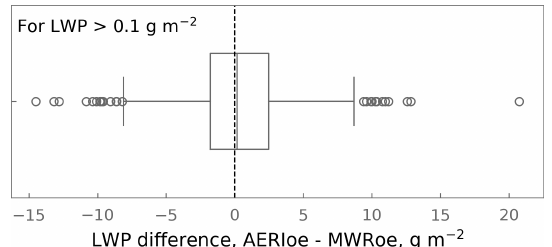
Figure 8. The differences in retrieved liquid water path (LWP) be- tween all AERIoe and the MWRoe retrievals (LWP > 0 . 1gm − 2 ). A total of 50% of all retrievals fall within the central box, 90% of all retrievals fall within the box plot “whiskers”, and the remaining data are plotted as outliers